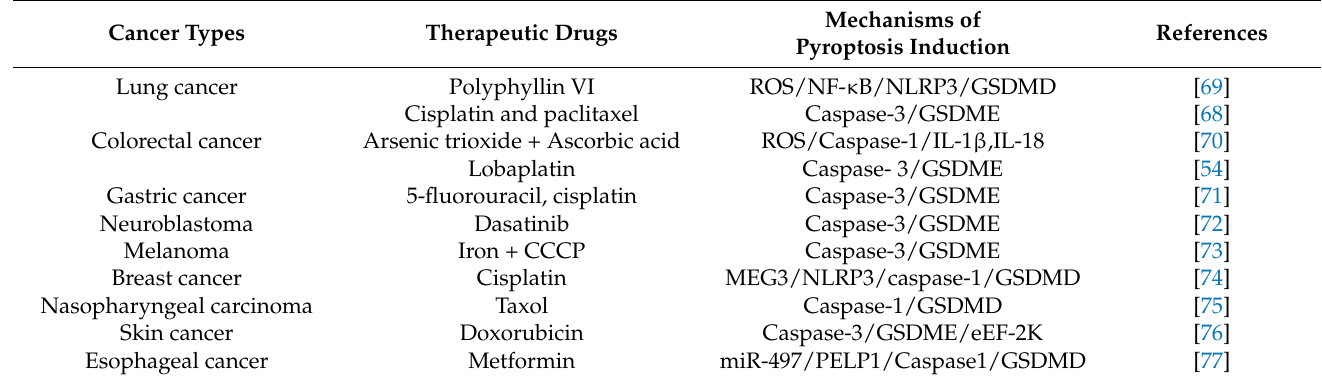
Table 2. Drugs inducing pyroptosis signaling pathways for regulating and treating